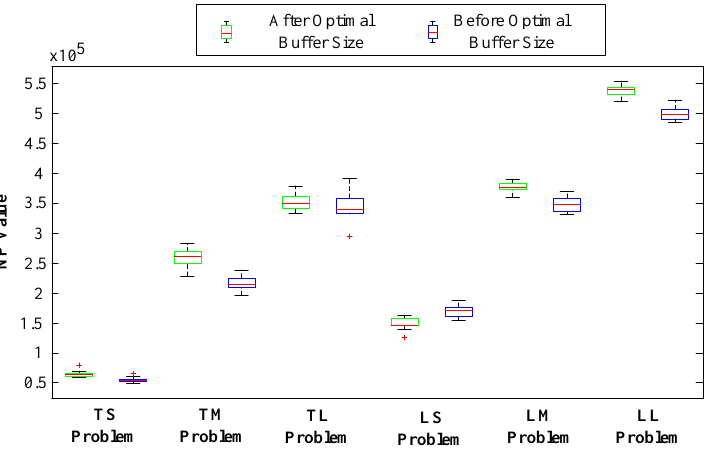
Figure 8. NP value for different categories of problems after and before using the optimal buffer size.